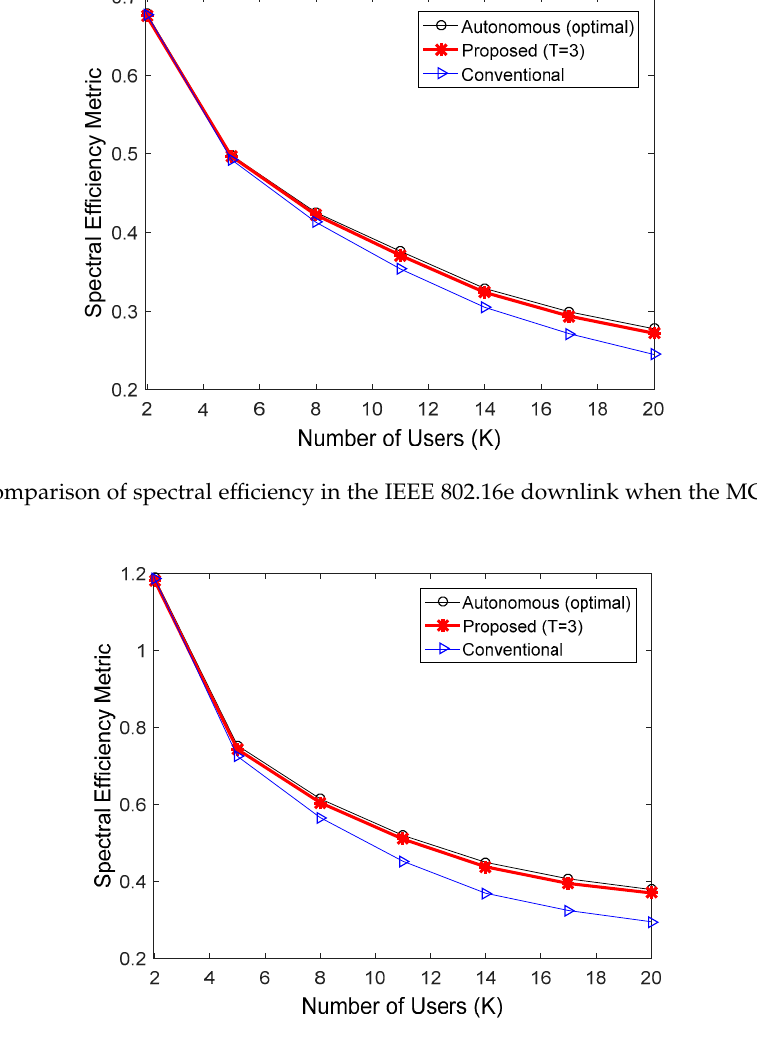
Figure 9. Comparison of spectral efficiency in the IEEE 802.16e downlink when MCS levels were dynamically changed over 4–11. Another advantage of the proposed HARQ is power saving of the sensor nodes. The transmission power of the MSs is proportional to the amount of uplink resources for feedback. Figure 10 compares the sum of required uplink resource for ACK/NACK feedback and optimal N for different values of